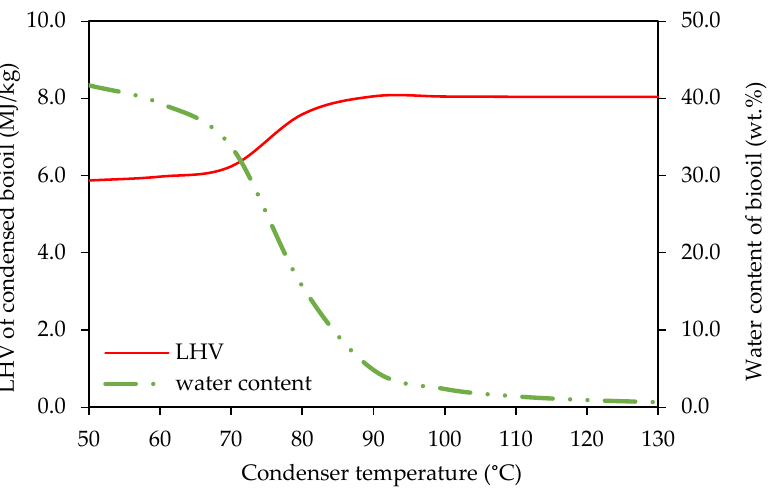
Figure 9. LHV and water content of bio-oil obtained from different condenser temperatures. Operating the condenser at a different temperature only slightly affects the total thermal efficiency of the system. As seen in Figure 10, at a higher condenser operating temperature, Scheme 2 has a higher η th value. Raising the condenser temperature from 50 to 130 ◦ C results in a merely 1% higher of η th value. This small change is mainly caused by the lower amount of heat loss at the condenser when it set to a higher operating temperature.